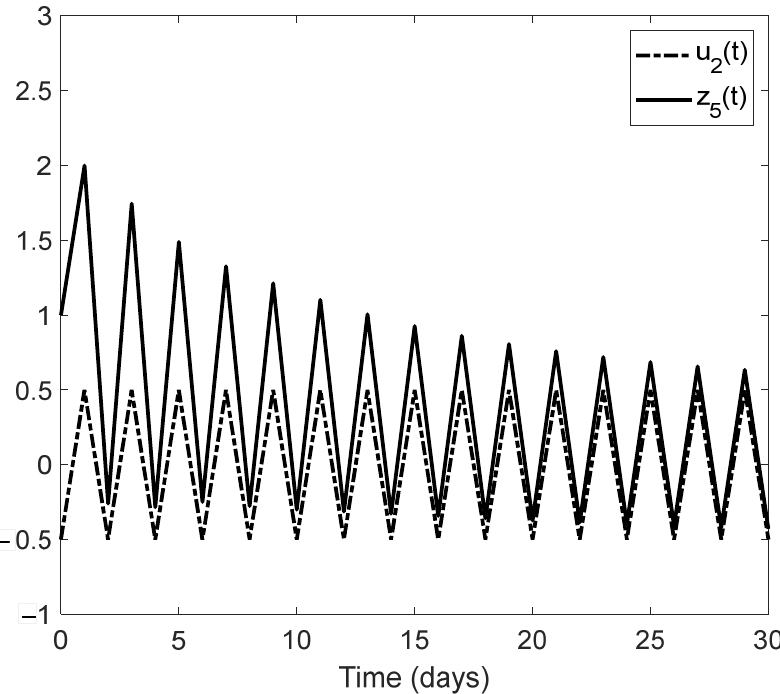
Figure 7. Estimation of the “unknown” environmental change, using the same observer as in Figure 6.